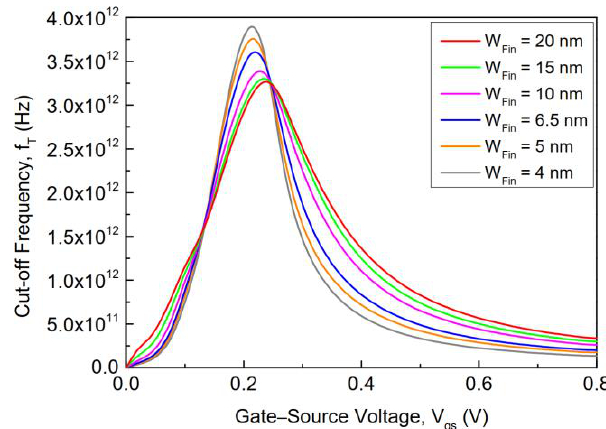
Figure 6. Cut-off frequency as a function of gate – source voltage with different values of the fin width at V ds = 0.05 V. The fin height is kept fixed at 26 nm.